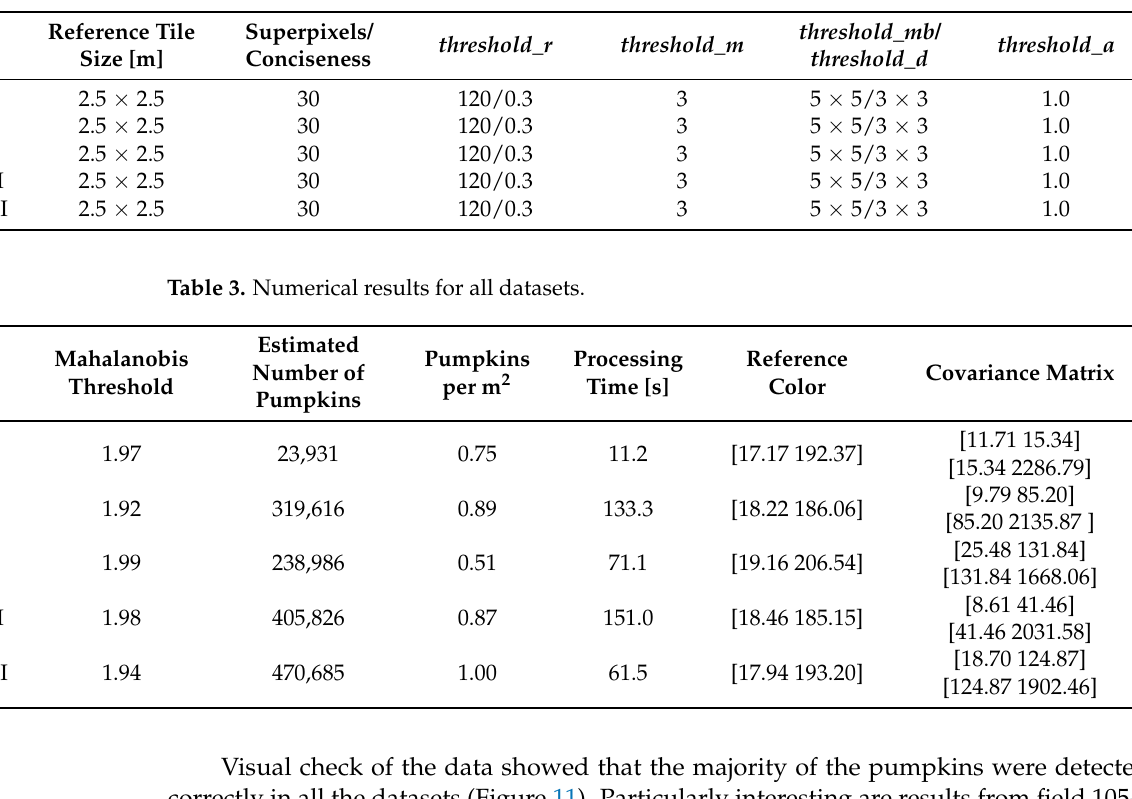
Table 2. Processing parameters for all datasets.